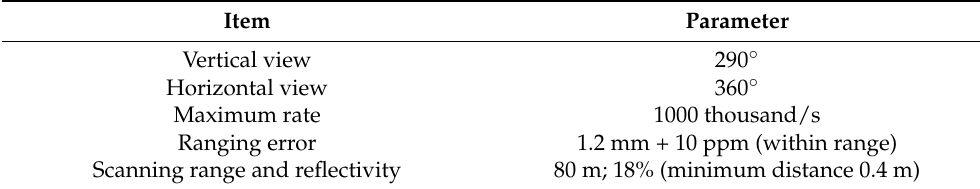
Table 4. Main parameters of the Leica ScanStation P16 scanner.